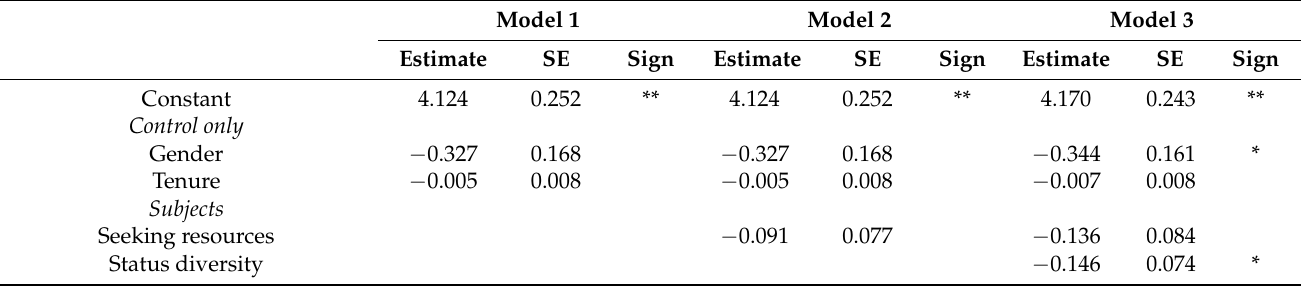
Table 6. Multilevel estimates of weekly seeking resources, perceived work group member status diversity on weekly